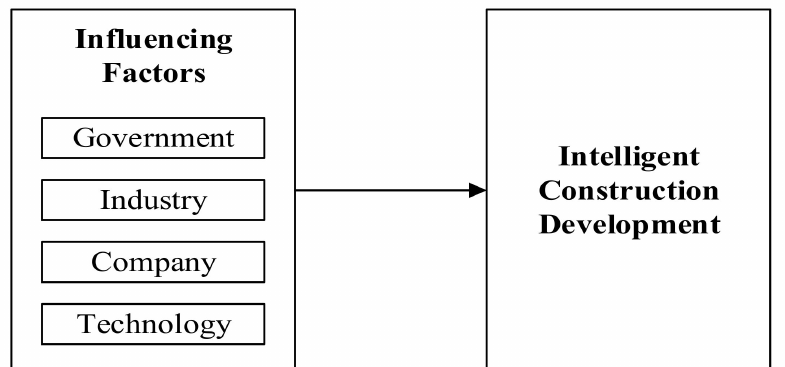
Figure 1. Conceptual research